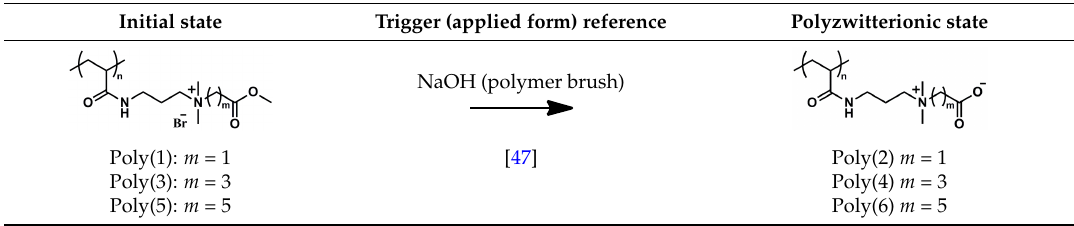
Table 1. Irreversible pH-triggered (meth)acrylic-based switches containing polyzwitterionic state. Initial state Trigger (applied form) reference